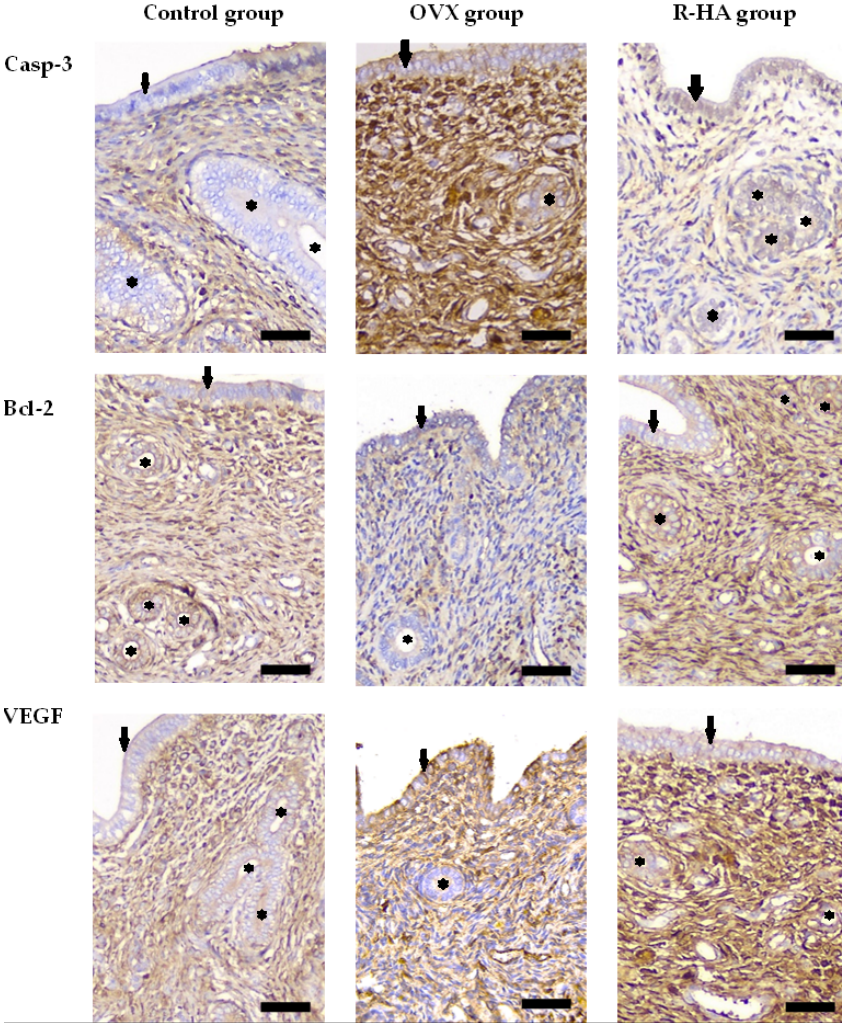
Figure 5. Changes in Casp-3, Bcl-2, and VEGF expression in experimental groups’ immunohisto- chemistry. Scale bars 50 µm. Ovariectomy resulted in thinning of endometrial lining epithelium (arrows), declining number of endometrial glands (asterisks), and changes in biomarkers expression. While Casp-3 expression increased in epithelium lining, endometrial stroma, and glands after ovariectomy, the levels of Bcl-2 dropped significantly in glandular cells as compared with the control group, shifting the balance between Casp-3/Bcal-2 towards pro-apoptogenic regulation. R-HA treatment attenuated the activation of pro-apoptogenic pathways through elevation and Bcl-2 ex- pression and reduction of Casp-3 levels especially in glands. This effect was associated with en- hancement of VEGF expression in both endometrial stroma and glands.